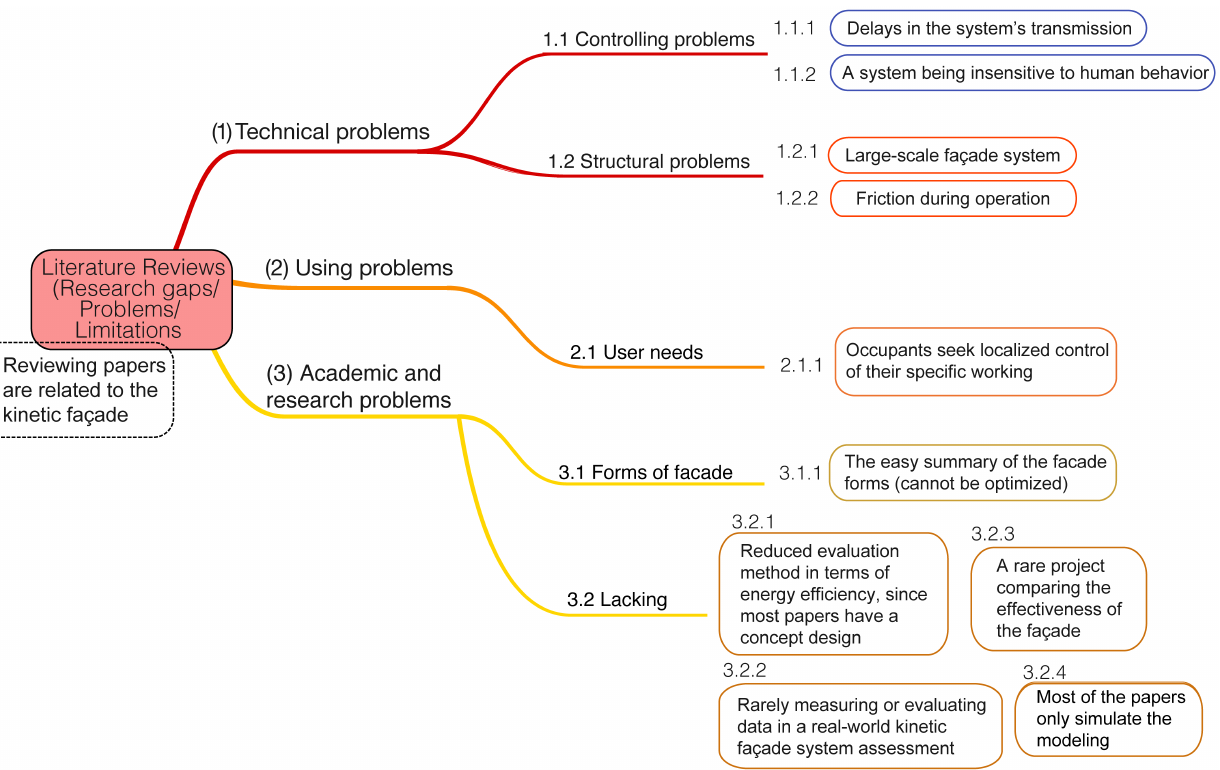
Figure 3. Summary of gaps, problems, and limitations of related